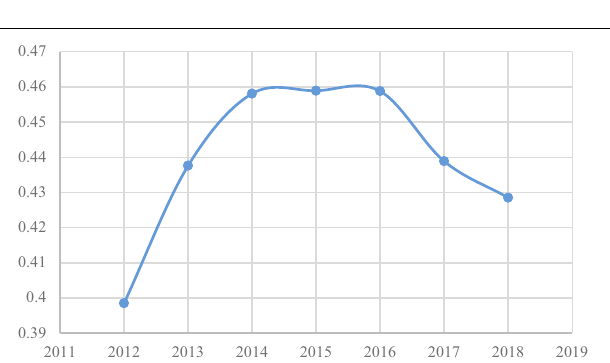
FIGURE 3 | Gini coefficient of logistics business in the 2012–2018 logistics area.